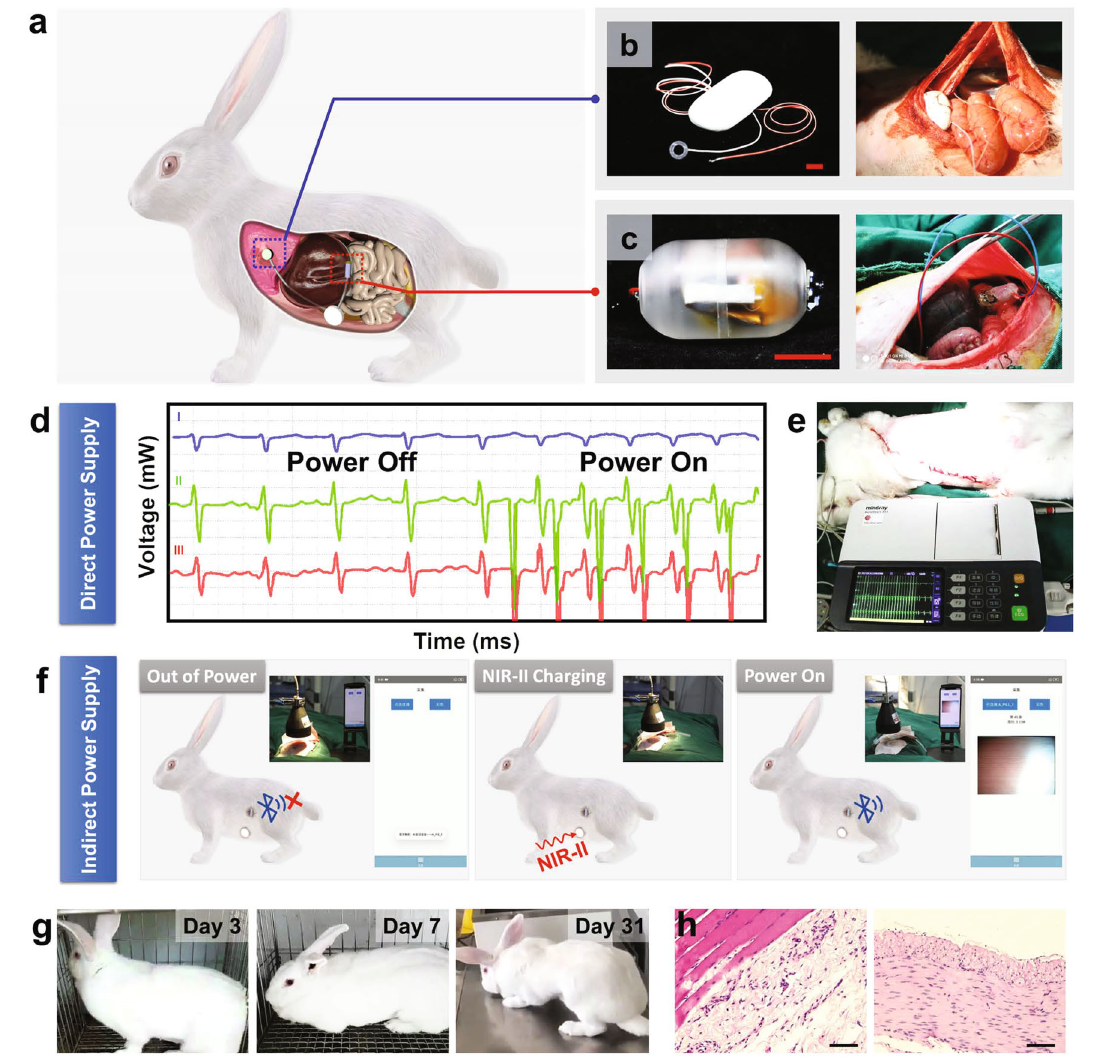
Fig.6|ThepowersupplyprovidedbyBio-PSforIMDsinrabbits.a Schematicof the corporation of Bio-PS and IMDs that are both implanted in rabbits. b Photographofacardiacpacemaker,anditsplacementinrabbit(inset).ScaleBar: 1.0cm. c Photograph of endo-photo camera that transmits images by Bluetooth, anditsplacementinrabbit(inset).ScaleBar:1.0cm. d Electrocardiogramrecorded under on – off irradiation. e Photograph of cardiac pacemaker powered by Bio-PS under NIR-II light irradiation. f The process of indirect power supply via Bio-PS for the endo-photo camera, and corresponding immediate imaging (inset). The